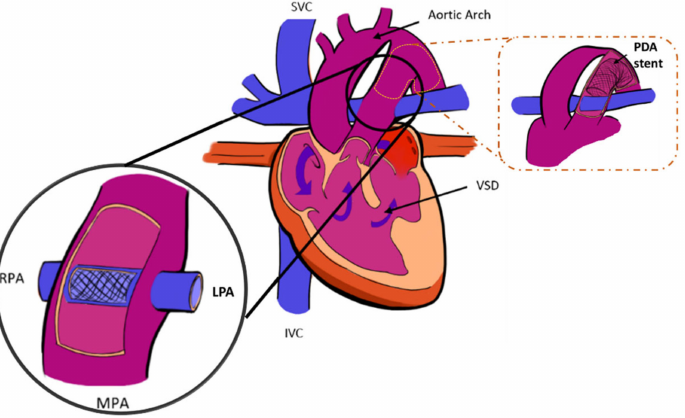
Figure 1. Schematic of the HCSII procedure [22] (p. 329) (MPA = main pulmonary artery, SVC = supe- rior vena cava, IVC = inferior vena cava, LPA = left pulmonary artery, RPA = right pulmonary artery, VSD = ventricular septal defect, PDA stent = patent ductus